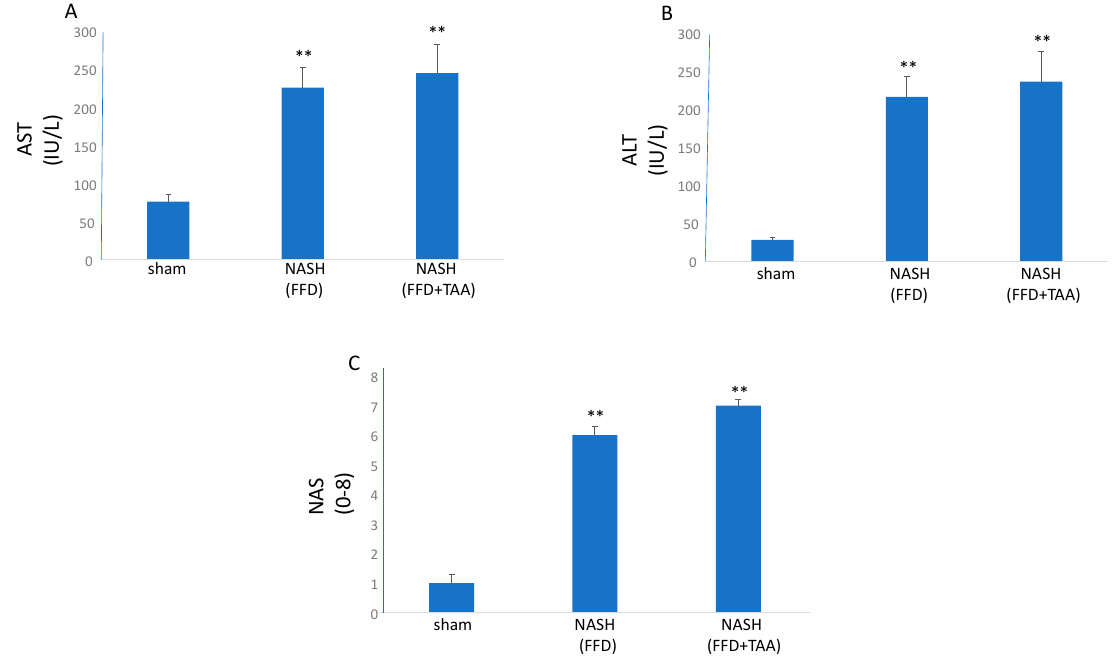
Figure 2. Nonalcoholic steatohepatitis (NASH). ( A ) and ( B ), Liver function tests and ( C ) NAFLD Activity Score (NAS) were elevated in the FFD and FFD + TAA cohorts compared to sham. ** p < 0.01 vs. sham.